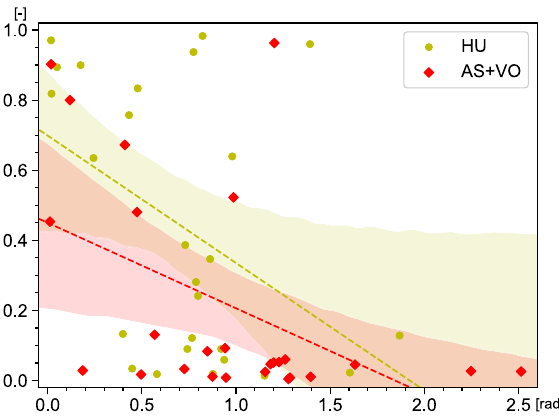
Figure 5. Scatter plot which shows the relationship between Phase Locking Index (PLI) [–] and the natural angular frequency difference | ω 0, l − ω 0, f | [rad/s] under HU (yellow) and AS+VO (red) conditions. The dotted lines indicate the estimated PLI for | ω 0, l − ω 0, f | . The shaded regions represent 95% confidence